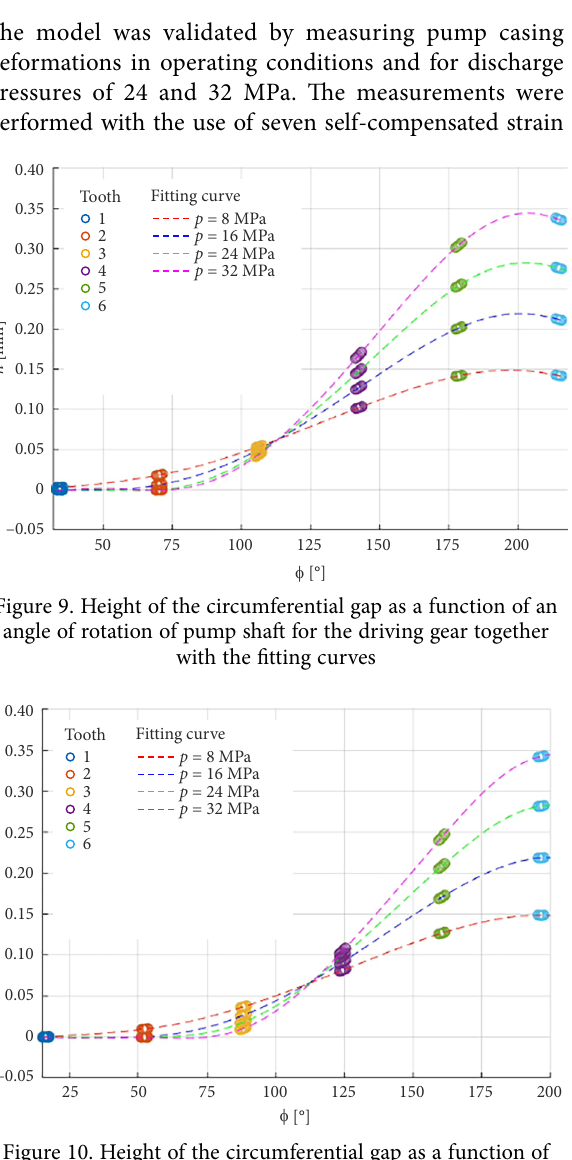
Figure 10. Height of the circumferential gap as a function of an angle of rotation of pump shaft for the driven gear together with the fitting curves